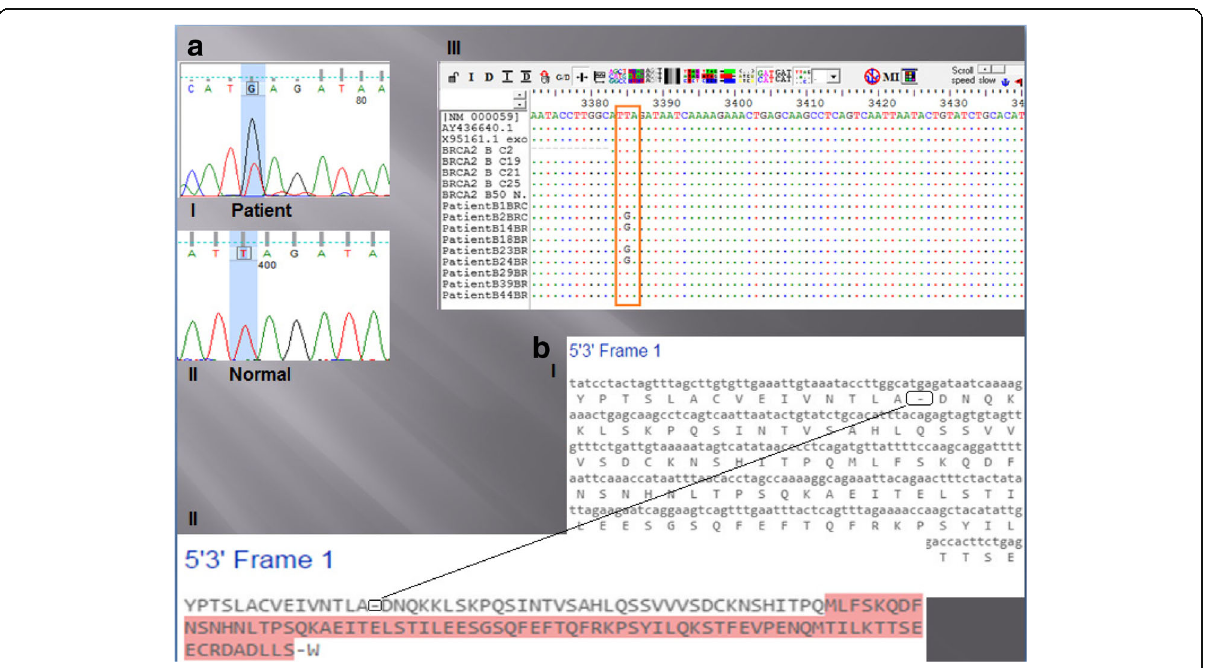
Fig. 2 a : I. patient. Illustrates the sequencing result of the chromatogram of one of the tested patients with the substitution mutation marked by a small square. The monoallelic change is more apparent. II. Control. Illustrates the sequencing result of the chromatogram of the control with the normal sequence. A - Adenine, G - guanine, T - thymine, C - cytosine. III. Illustrates Bioedit multiple sequences alignment with substitution of thymine by guanine. b : I. This frame illustrates the nucleotide sequence (in small letters) and their corresponding amino-acids sequence (in capital letters) of a selected frame (5' to 3' frame 1) of the tested region (region B) of BRCA2 . The dash ( − ) represents absence of amino-acid (stop